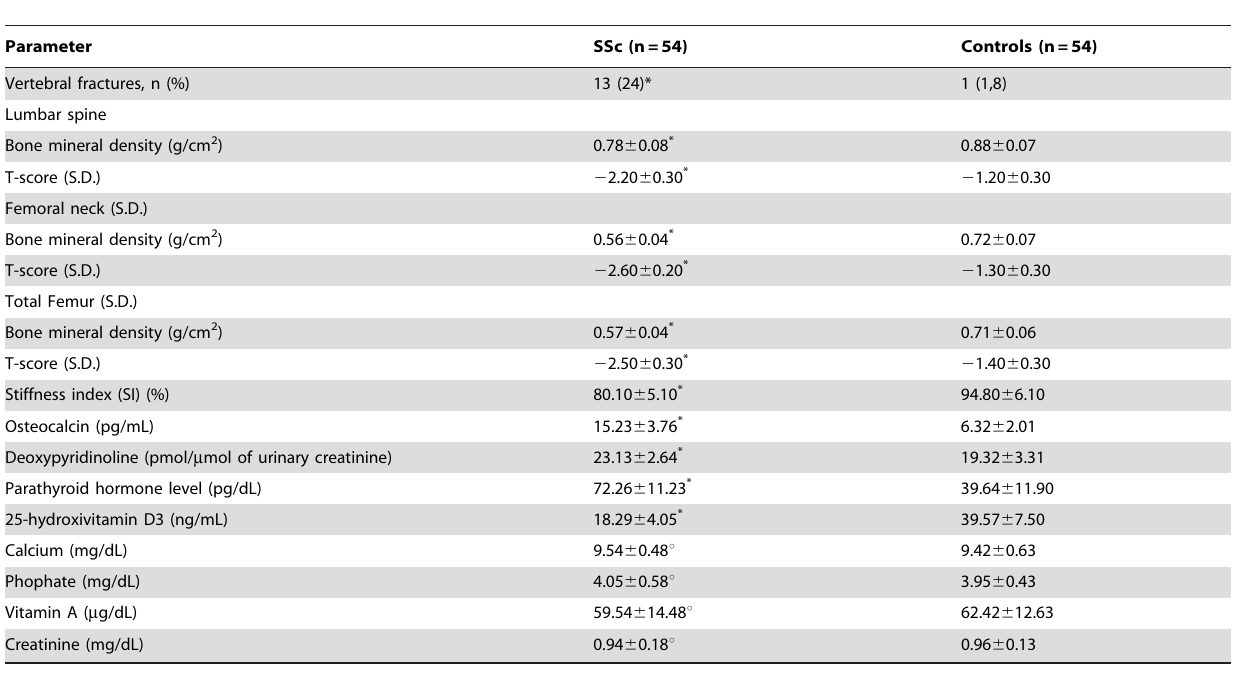
Table 2. Bone mineral density results and laboratory finding in women with SSc and control group. a